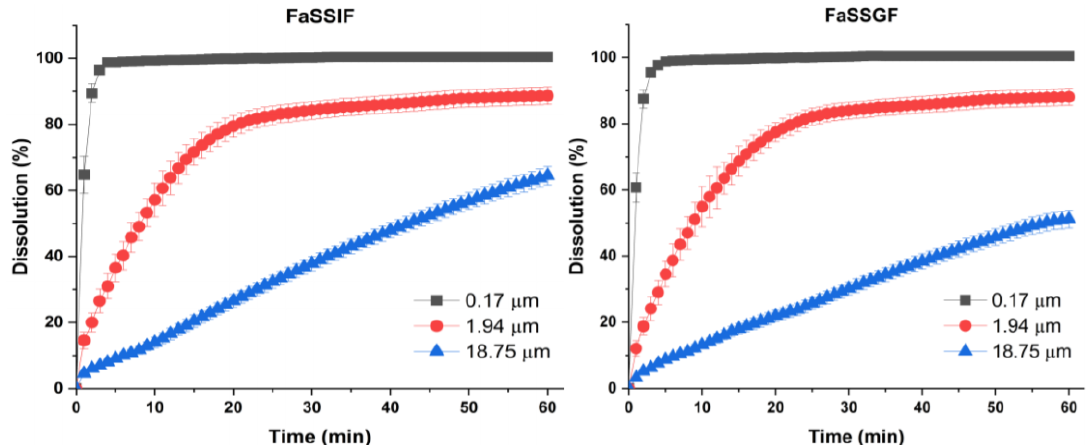
Figure 4. E ff ect of particle size on the dissolution of trans -resveratrol in the fasted state-simulated Figure 4. Effect of particle size on the dissolution of trans ‐ resveratrol in the fasted state ‐ simulated gastric fluid (FaSSGF) and fasted state simulated intestinal fluid (FaSSIF). gastric fluid (FaSSGF) and fasted state simulated intestinal fluid (FaSSIF). Table 3. Dissolution rate and simulated 50% dissolution time of the trans -resveratrol nanoparticles Table 3. Dissolution rate and simulated 50% dissolution time of the trans ‐ resveratrol nanoparticles